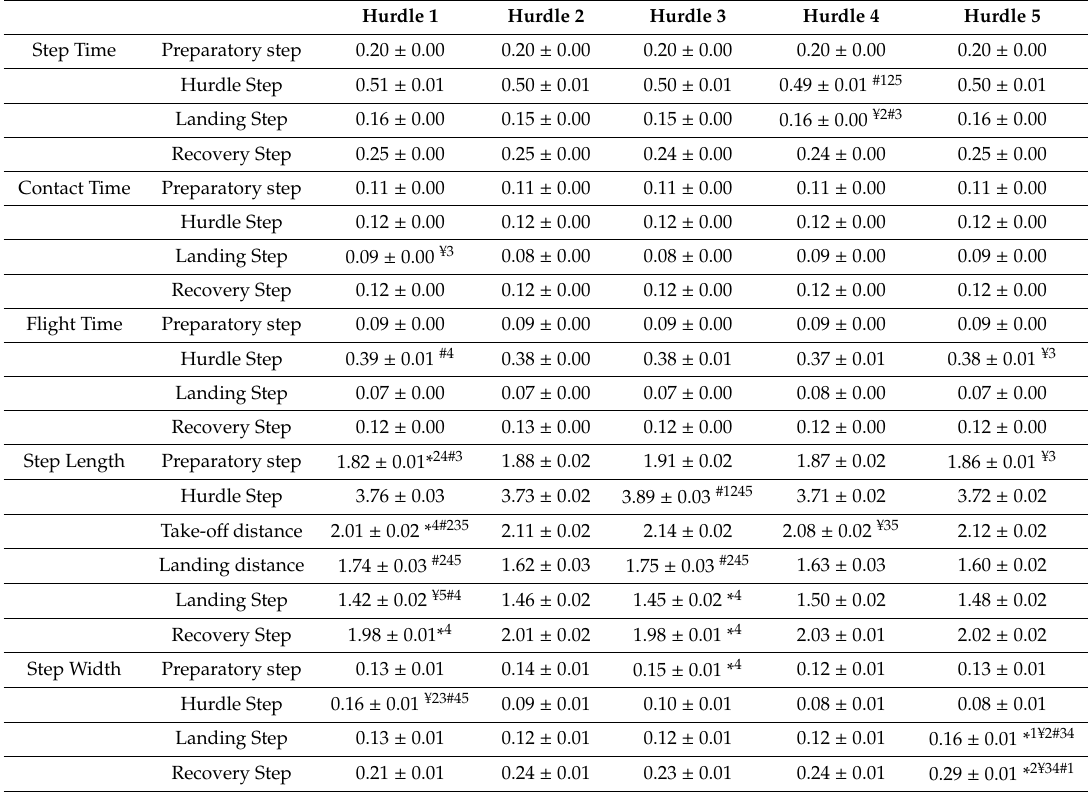
Table 2. Evolution of the spatial-temporal variables of men hurdlers participating in the 44th Spanish Indoor and 12th IAAF World Indoor Championships.